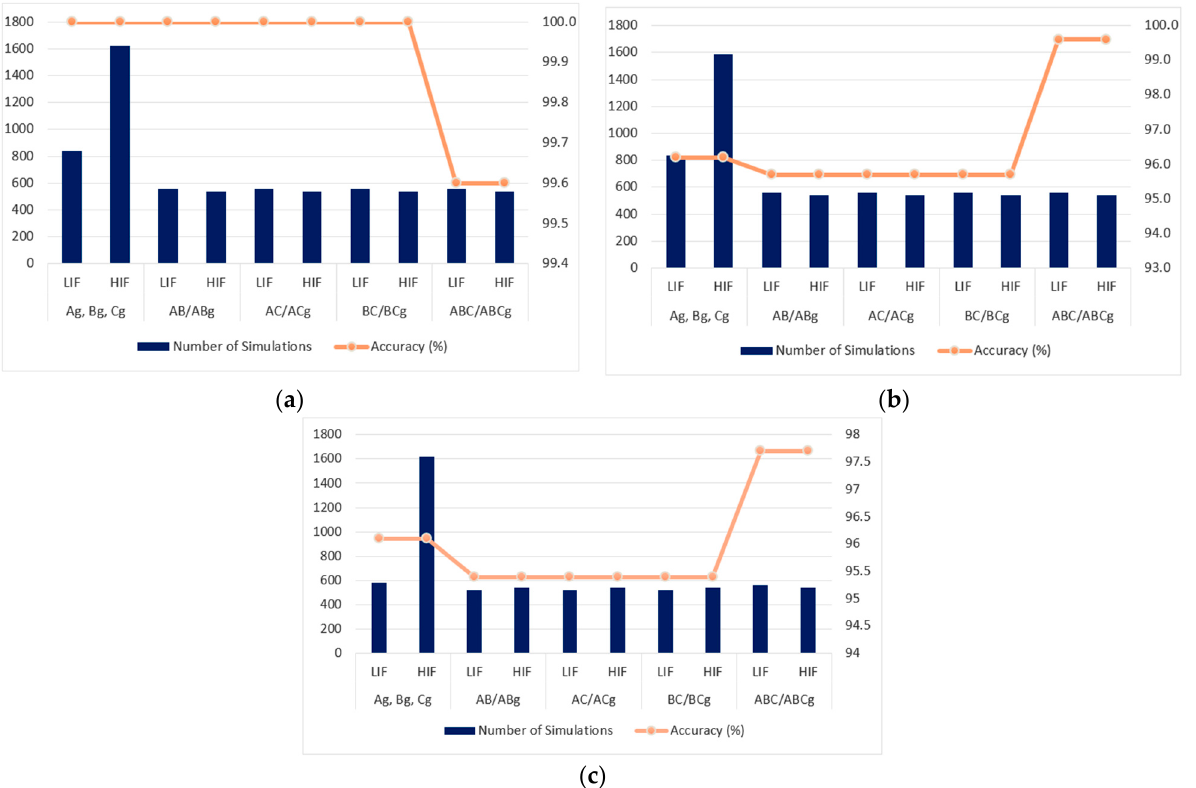
Figure 10. Short-circuit classification for three scenarios: ( a ) without DG units (scenario 1), ( b ) with two synchronous generators (scenario 2), and ( c ) with PV panels (scenario 3). Table 6. Membership functions parameters for FIS input variables.